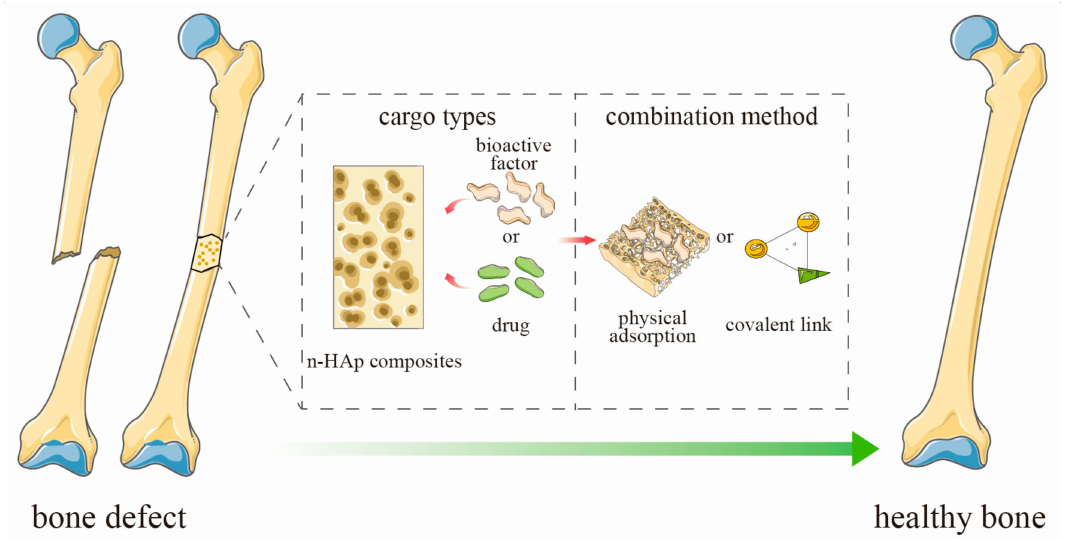
Figure 1. Schematic representation of n-HAp composite scaffold loaded with bioactive factors or drugs for bone